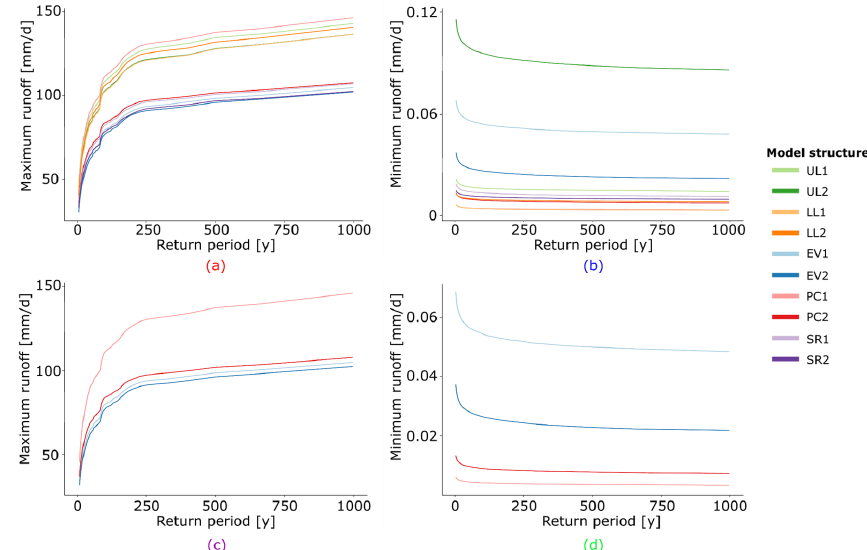
Figure 5. The ensemble mean of the annual maximum (a, c) and minimum (b, d) daily runoff levels at different return periods in the tropical climate zone. The ensemble mean is obtained based on 100 parameter sets. In panels (a) and (b) all model structures are visualised. In panels (c) and (d) , a selection of only four model structures is presented to emphasise the difference between the model structures. These four model structures are related by alterations in the evaporation (EV1, EV2) and percolation (PC1, PC2) process formulations (Table 1). The colours of the panel labels refer to the boxes of the same colours in Fig.